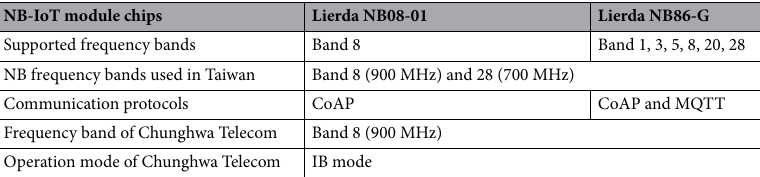
Table 2. Comparisons between the NB-IoT module chips.